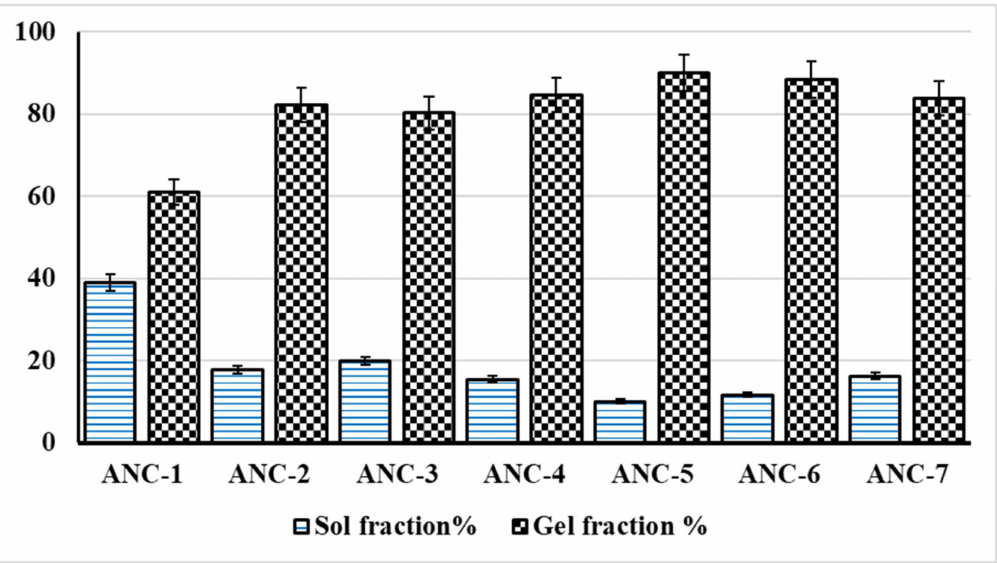
Figure 1. Sol-gel analysis of developed nanomatrices (ANC-1 to ANC-7) formulations.